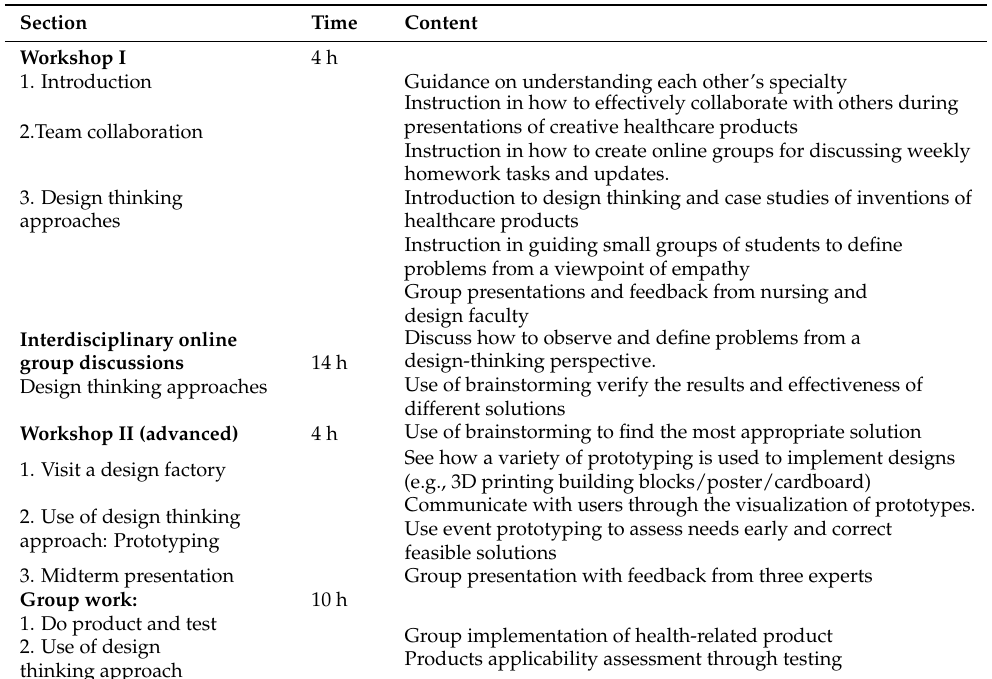
Table 1. The Interdisciplinary Teaching Intervention Program: The three 4-h workshops, and content of the 18-week capstone